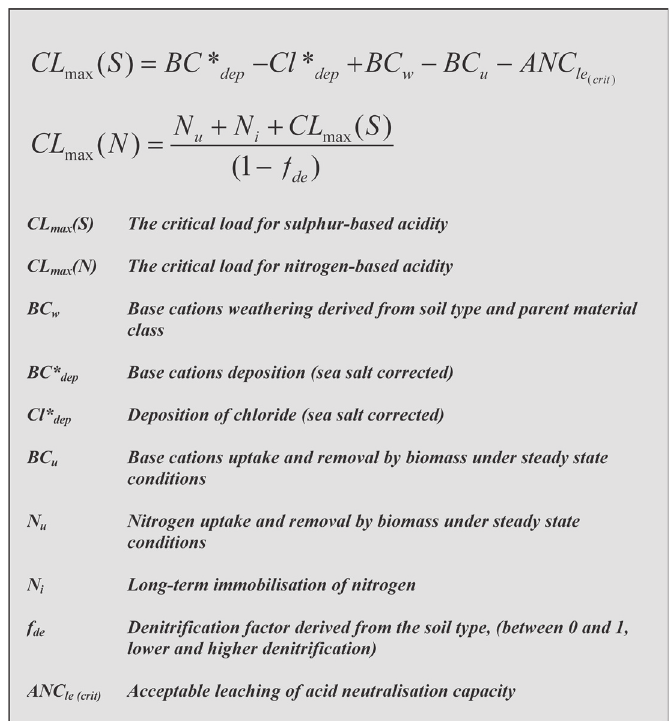
FIGURE 3 . Derivation of critical loads for acidity (sulphur and